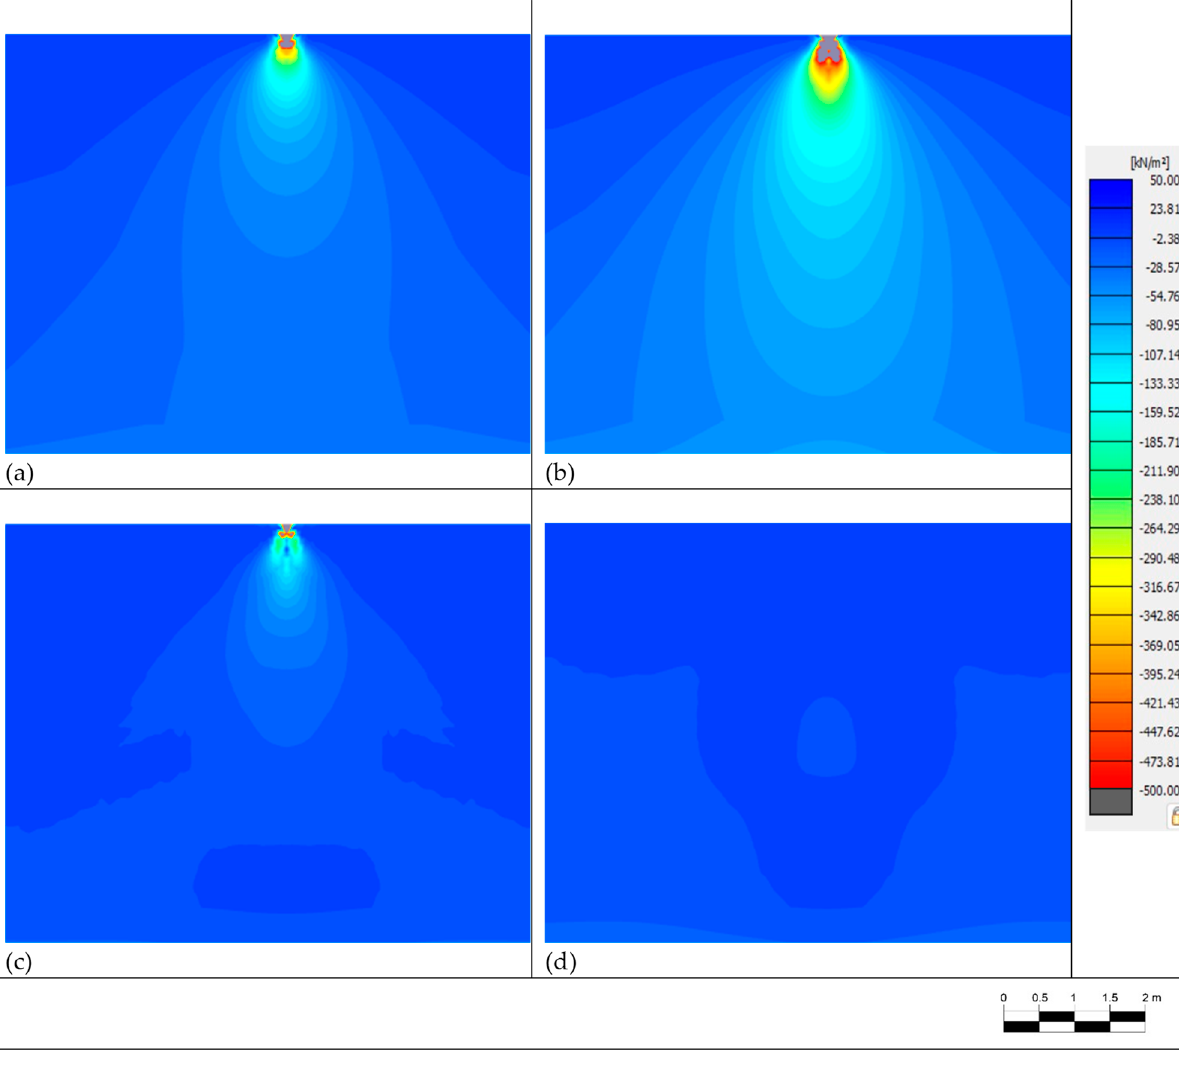
Table 3. The results of the FEM calculation for the three combinations of Young modulus and colli- sion duration (or maximum force).